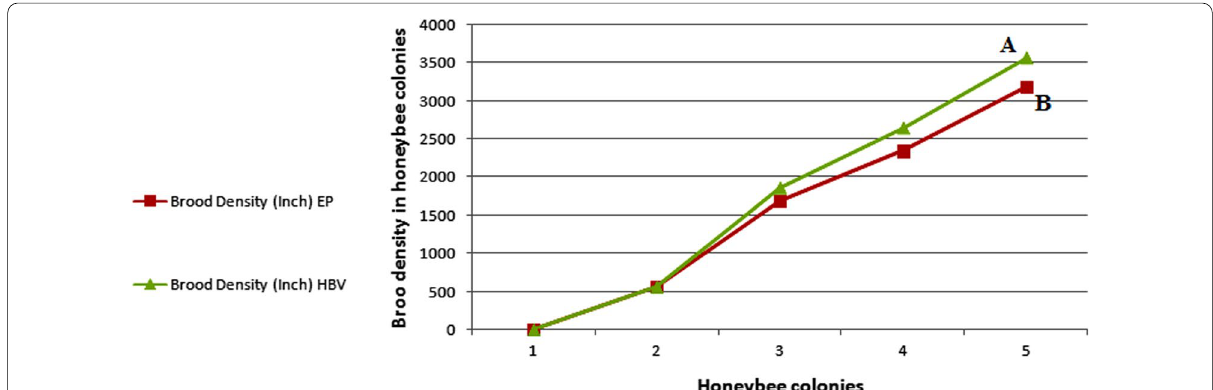
Fig. 1 The average of brood density in honeybee colonies showed in line A: the treated colonies with honeybee venom (HBV) concentrations more than line B: the treated colonies with Egyptian ethanolic propolis extract